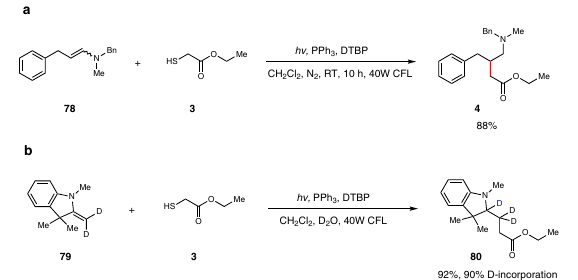
Fig. 5 Experimental observations for the proposed mechanism. a Direct addition to the enamine. b Deuterium-labeling